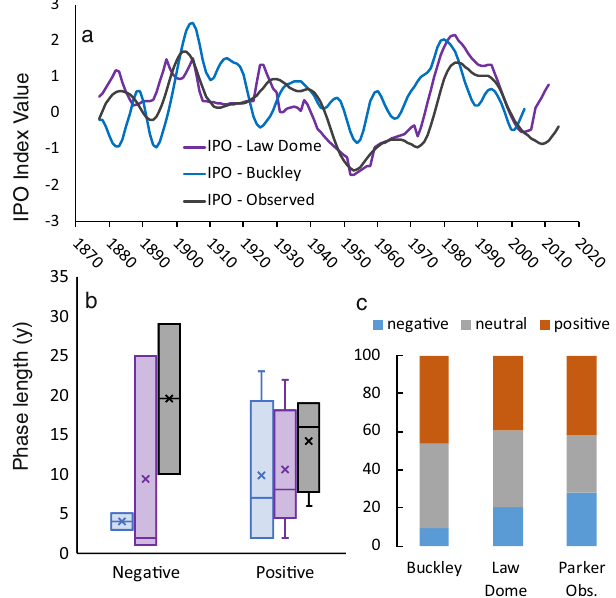
Fig. 1 IPO Index and reconstruction characteristics over the observational period 1877 – 2014. a Comparison of observed Parker et al. IPO index (1877 – 2014, black), Buckley et al. IPO reconstruction (1877 – 2004, blue) and Law Dome IPO reconstruction (1877 – 2011, purple). b Box plots of positive and negative phase lengths (same colour scheme) for each timeseries over the same time period, with the caveat that only complete phases for any given series were included in the phase length analysis. Boxplot elements shown are the mean (X), median (midline), interquartile range (IQR — box boundaries) and data points outside the IQR but within 1.5× quartile range (whiskers). Numbers of phases were 6, 5 and 4 positive and 3, 2 and 2 negative for the Buckley et al., Law Dome and Observed series, respectively. c Percent time in each phase and neutral over the observed period (positive >0.5, neutral − 0.5 to 0.5 and negative < − 0.5). See Table 1 for more